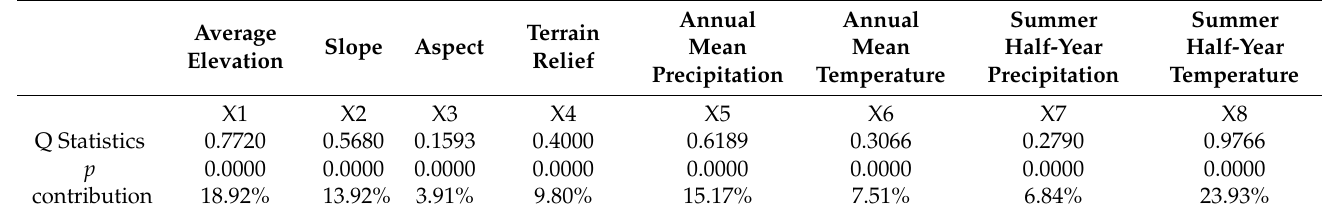
Table 6. Response of topographic and climate factors to glacier